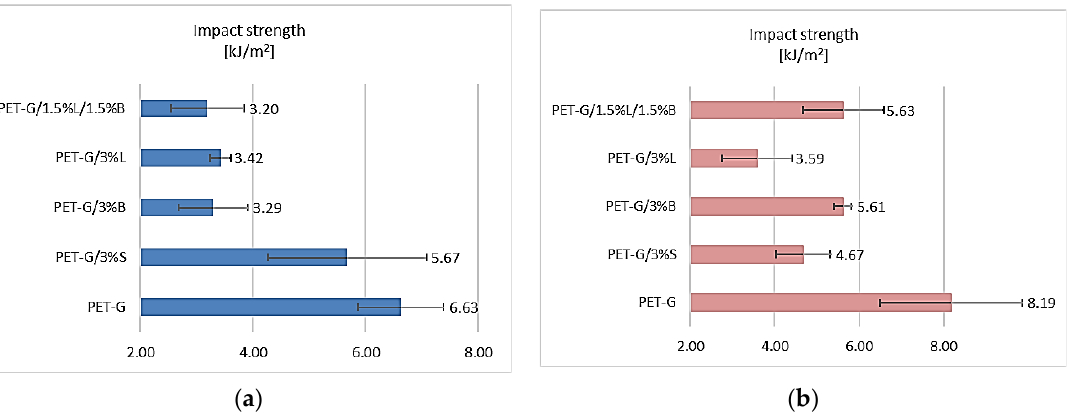
Figure 5. Impact strength test results of ( a ) samples obtained by 3D printing and ( b ) samples obtained by injection molding.